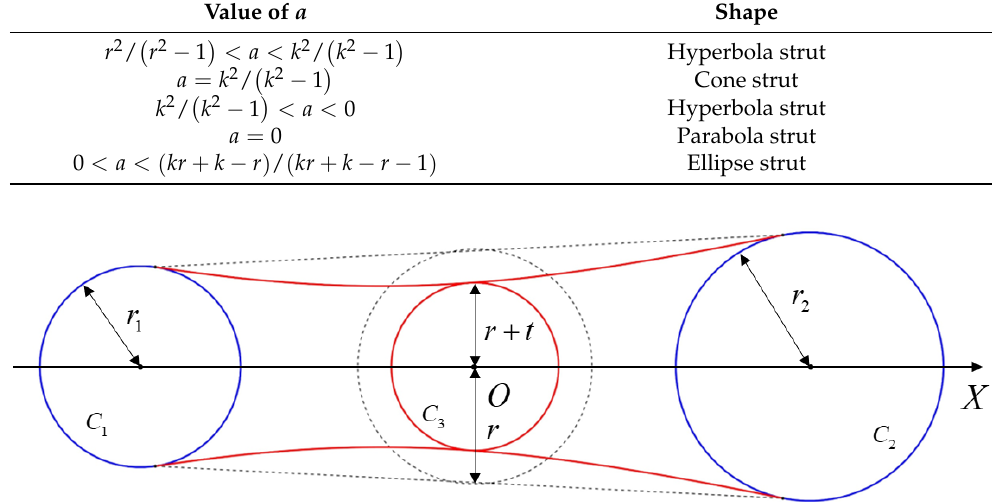
Table 1. Strut type defined by a . Value of a Shape